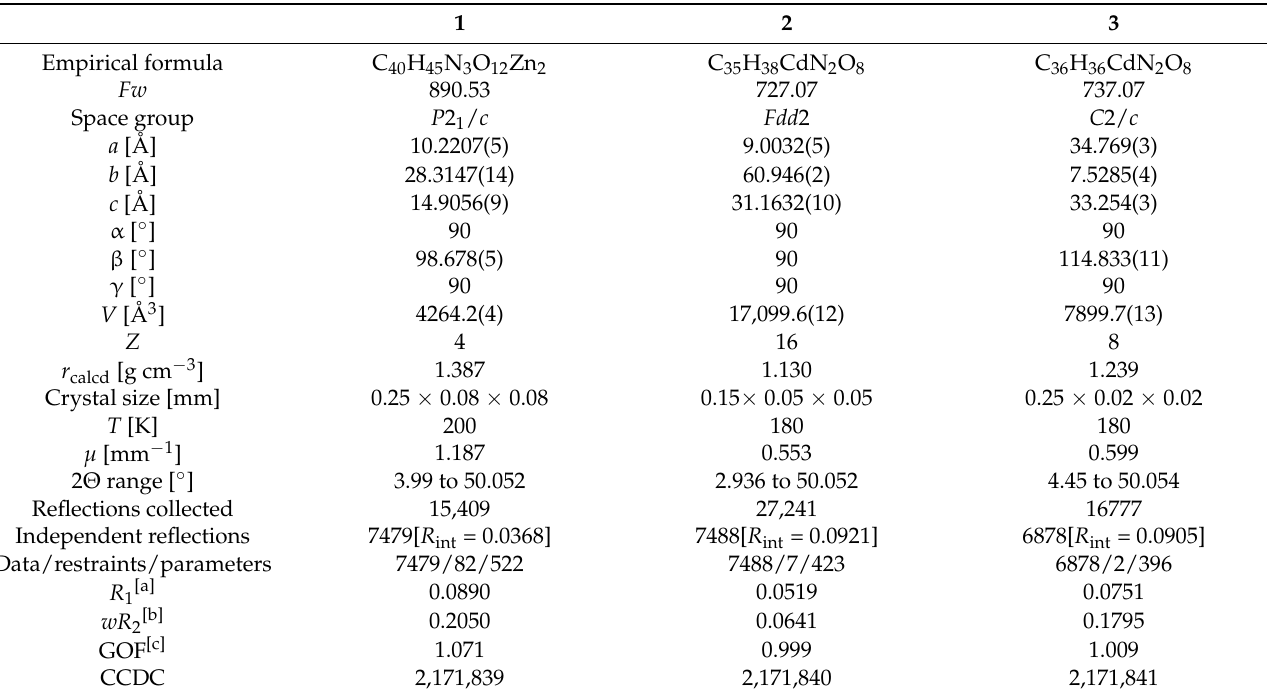
Table 1. Crystal data and details of data